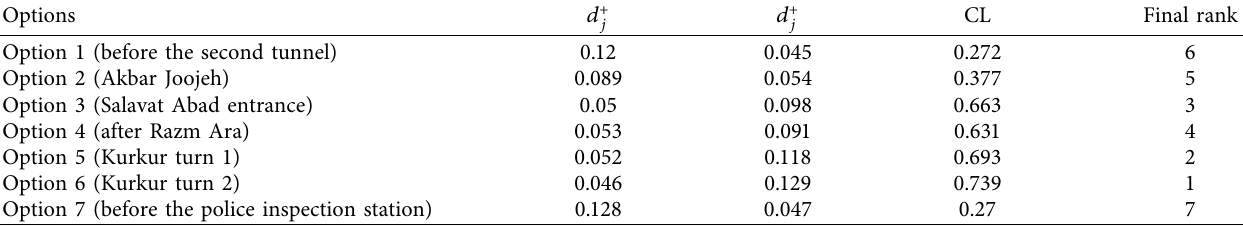
Table 17: Calculated CL values.